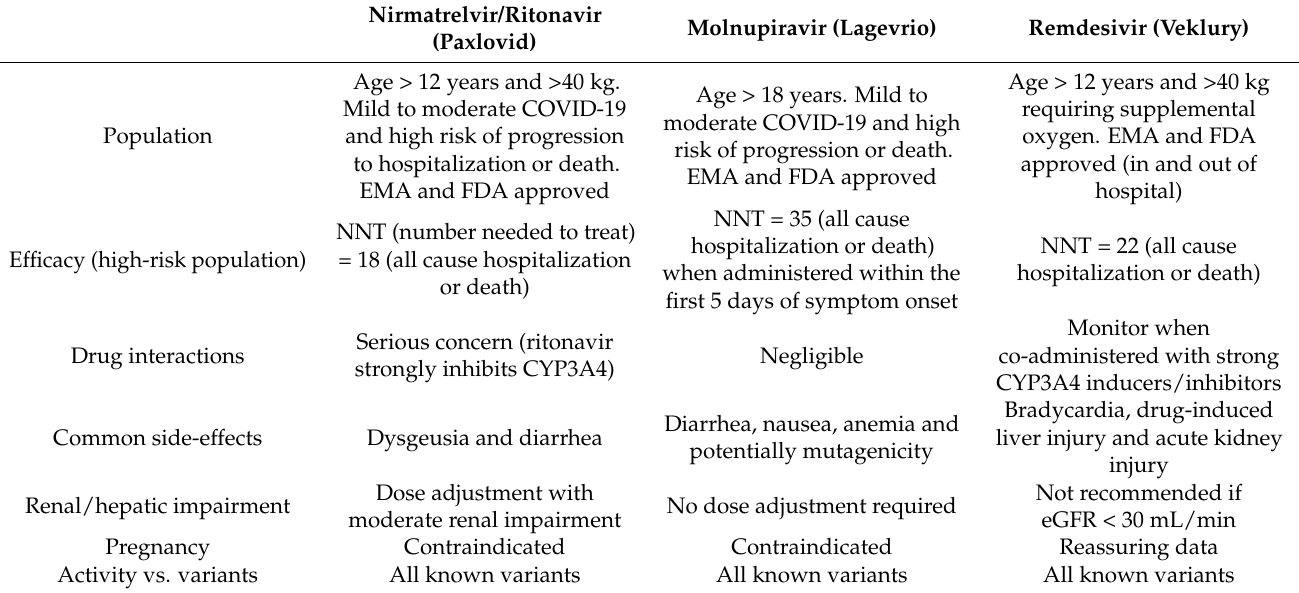
Table 7. Overview of SARS-CoV-2